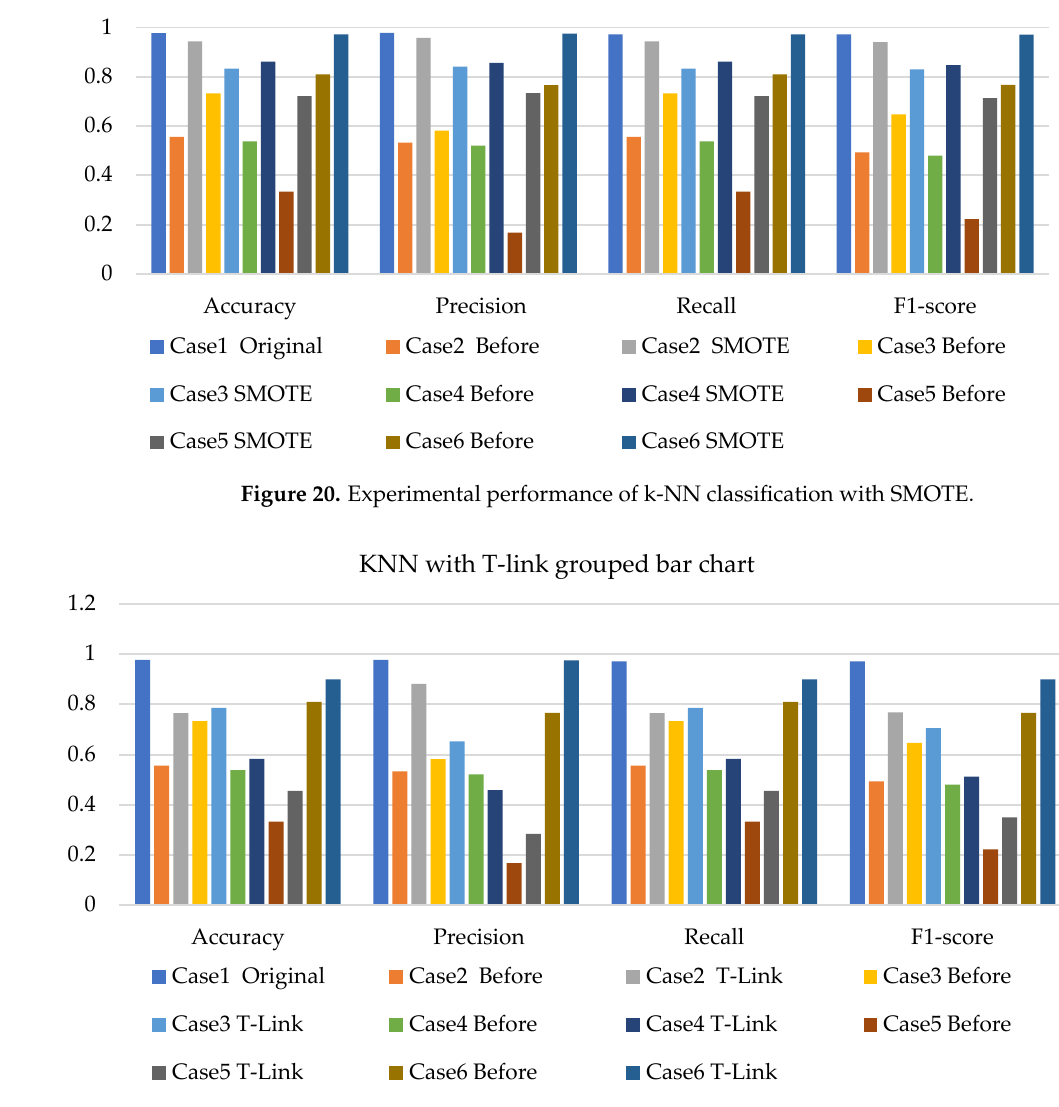
Figure 22. Experimental performance of k-NN classification with SMOTE/T-link. 4.3. Discussions In this study, T-link was performed in a data-handling pipeline to address imbal- anced data in both simulation and experiments. For the simulation testing, the NBC per- formance after applying T-link presents improved results compared to original imbal- anced data and NBC with SMOTE. The combination of SMOTE and T-link provided im- proved results in some cases, and in other cases, the performances present improvement compared to SMOTE results and underperformance compared to T-link. For experimental testing, the NBC with SMOTE presented improved and higher performance results com- pared to T-link and also outperforms the combination of SMOTE/T-link. The NBC with resampling methods for simulated and experimental data has a minimum of 40% and 50% and a maximum of 78% and 75%, respectively.